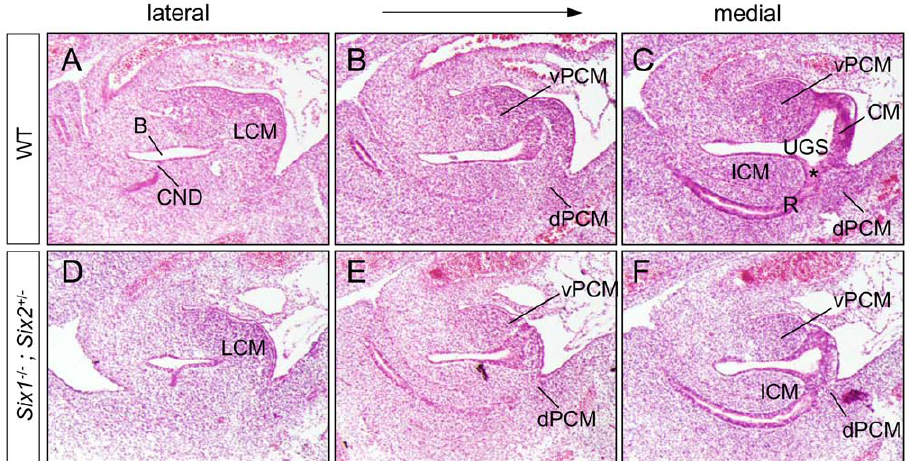
Figure 5. Hypoplastic genital tubercles of Six1;Six2 compound mutants at e11.5. Hematoxylin and eosin (H&E) staining of the serial sagittal sections of e11.5 urogenital structure. Asterisk, juxtaposition of ICM, dPCM and the cloacal membrane (CM); B, bladder; CND, common nephric duct; lPCM, lateral PCM; R, rectum; see Figure 1 for more abbreviations.